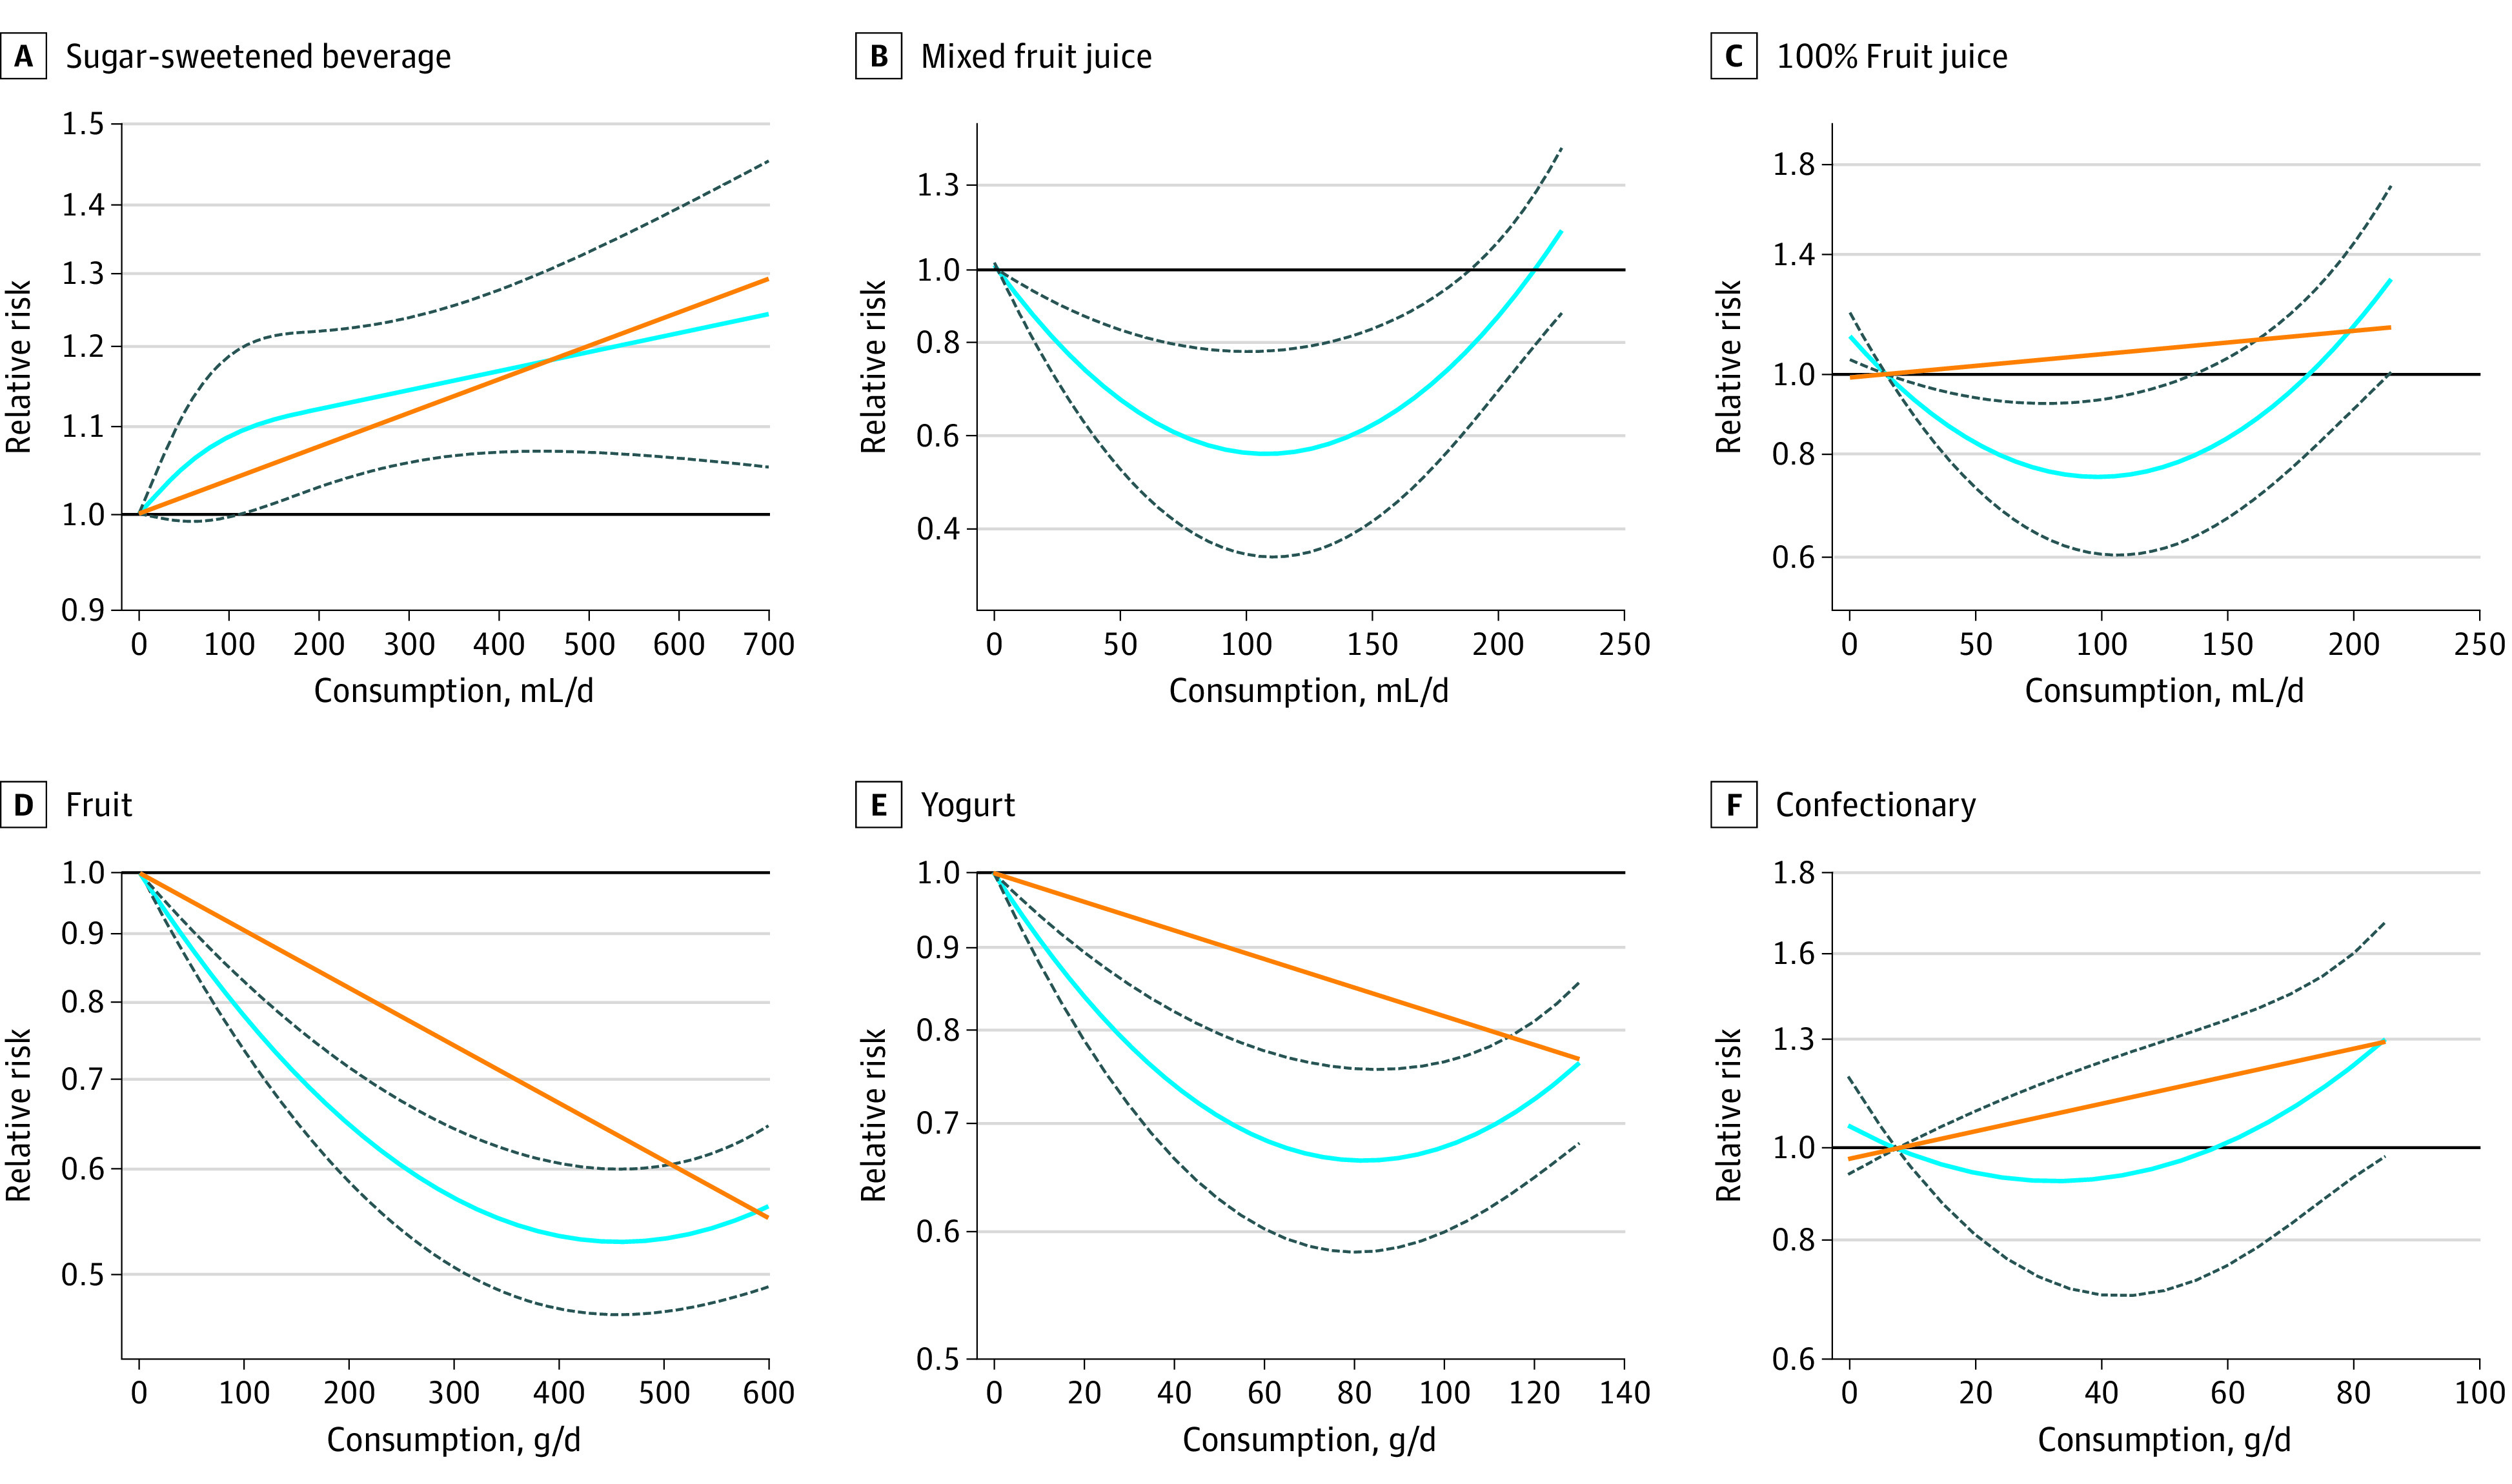
Dose-Response Association of Food Sources of Fructose-Containing Sugars and Incident Metabolic SyndromeDose-response association between intake of sugar-sweetened beverages (linearity: risk ratio [RR] per 355 mL, 1.14; 95% CI, 1.05-1.23; P = .001; departure from linearity: RR per 355 mL, 1.16; 95% CI, 1.07-1.26; P = .27) (A), mixed fruit juice (linearity: RR per 125 mL, 1.00; 95% CI, 0.87-1.14; P = .96; departure from linearity: RR per 125 mL, 0.58; 95% CI, 0.42-0.79; P < .001) (B), 100% fruit juice (linearity: RR per 125 mL, 1.09; 95% CI, 0.93-1.27; P = .31; departure from linearity: RR per 125 mL, 0.77; 95% CI, 0.51-0.97; P < .001) (C), fruit (linearity: RR per 80 g, 0.92; 95% CI, 0.91-0.94; P < .001; departure from linearity: RR per 80 g, 0.82; 95% CI, 0.78-0.85; P < .001) (D), yogurt (linearity: RR per 85 g, 0.92; 95% CI, 0.91-0.94; P < .001; departure from linearity: RR per 85 g, 0.66; 95% CI, 0.58-0.76; P < .001) (E), and confectionary (linearity: RR per 50 g, 1.18; 95% CI, 0.98-1.42; P = .07; departure from linearity: RR per 50 g, 0.96; 95% CI, 0.71-1.30; P = .17) (F) with the risk of metabolic syndrome. The solid orange line represents the linear model and the blue line the nonlinear model. Dotted lines represent 95% CIs for the nonlinear model.